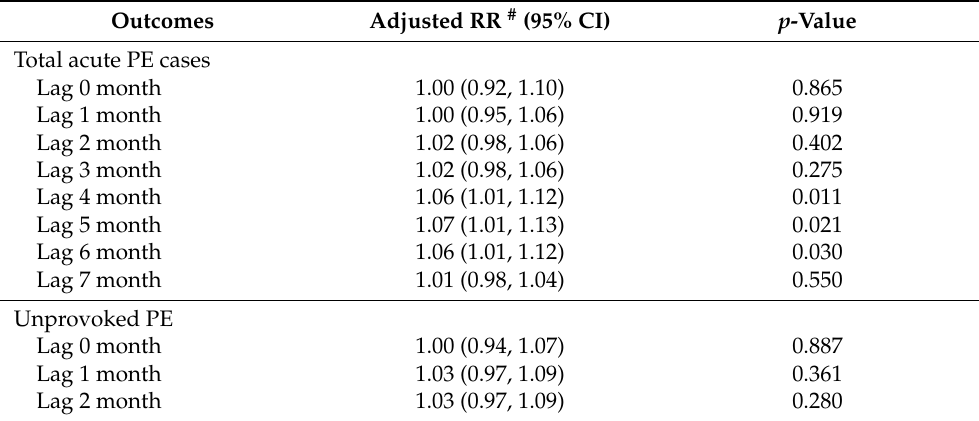
Table 6. Associations between every 10 µ g/m 3 increase in PM 10 and monthly APE cases (total), unprovoked PE and provoked PE (October 2010–December